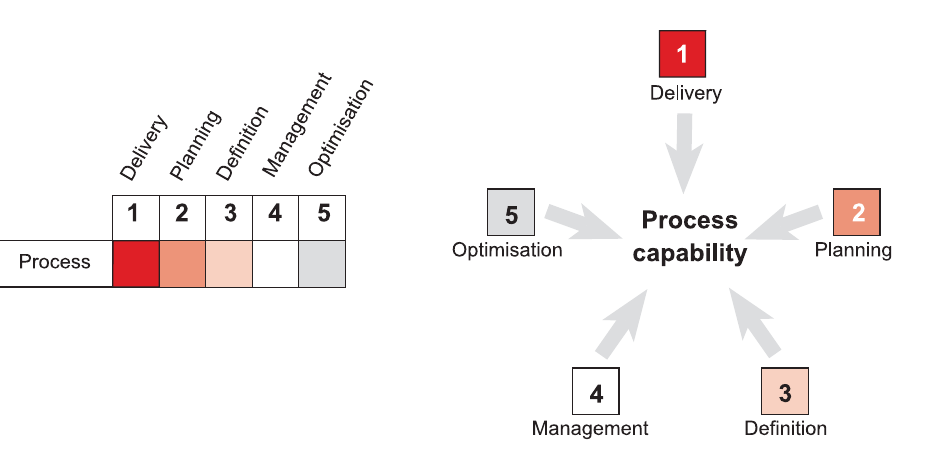
Figure 1. eMM process dimensions.